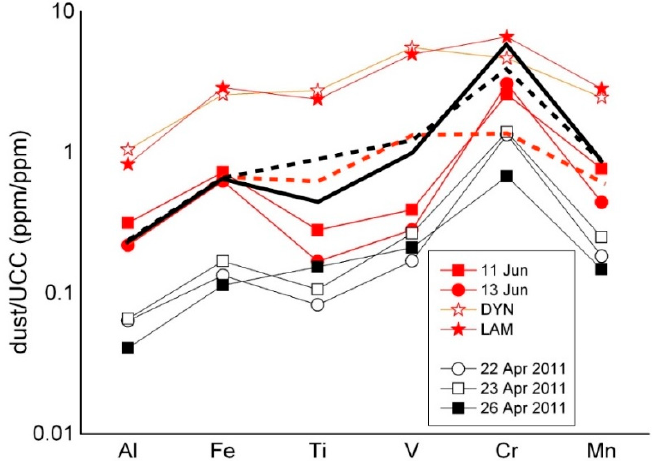
Figure 8. Metal concentrations in the aerosol samples from Iceland (11 and 13 June), compared to Icelandic volcanic sands from Dynjusandur (DYN) and Lambahraun (LAM; after [12]), and to Icelandic aerosol samples collected in Ny-Ålesund in April 2011 [16]. The mean trend of DYN and LAM sands (red dashed line), the trend of 26 April 2011 (black dashed line), and the mean trend of 22 and 23 April 2011 (black sold line) have been shifted over the trend of 11 and 13 June in order to be compared.